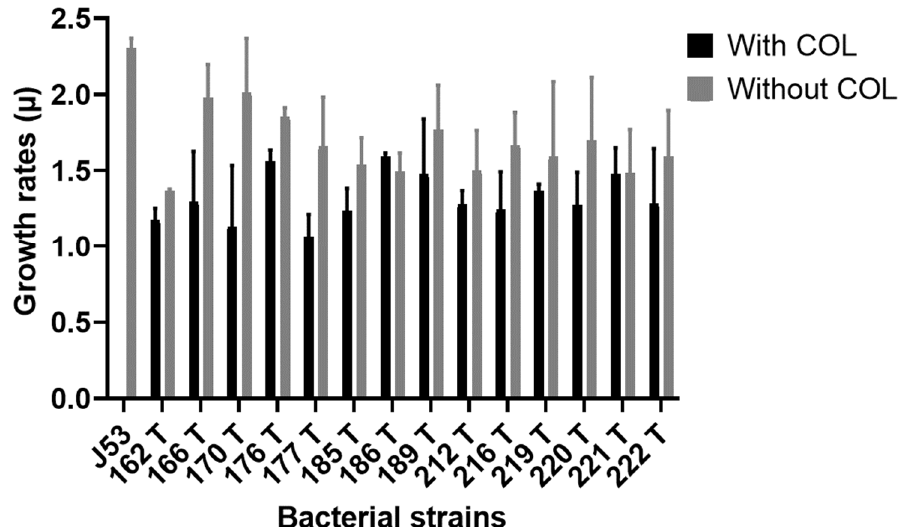
Figure 1. Growth kinetics assay results. Growth kinetics assays revealed that transconjugants have a mean growth rate of 1.66 in absence of COL (blue bars) and 1.32 in presence of COL (purple bars), p -value = 0 . 0003.